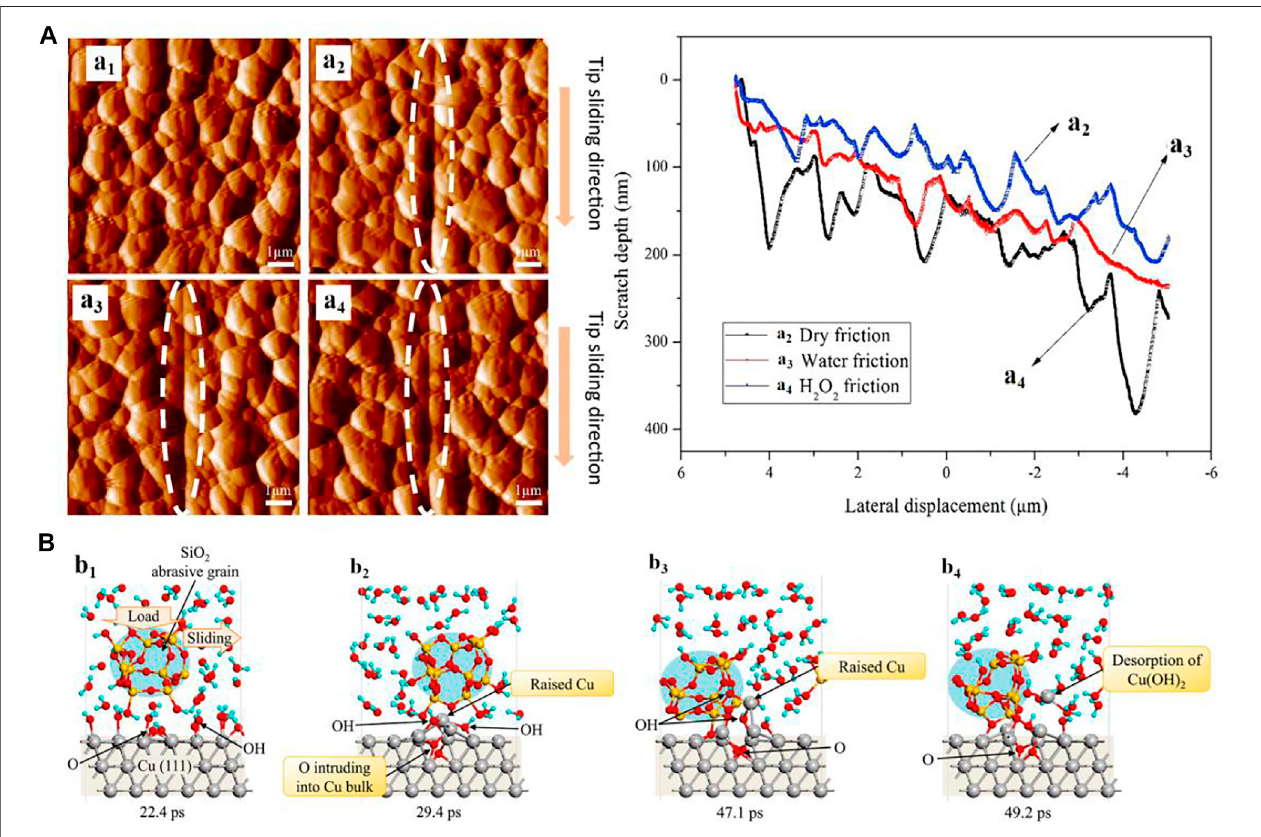
FIGURE 5 | (A) Morphologies of the Al surfaces before (a 1 ) and after the scratch tests in dry condition (a 2 ), DI water (a 3 ), and aqueous H 2 O 2 (a 4 ) with the pro fi les of scratch scars under the corresponding environments (right plots). Adapted from Yongguang Wang et al., 2019 (B) MD simulations showing the tribochemical wear process of Cu (111) sliding against a SiO 2 abrasive grain in H 2 O 2 solution. Adapted from Kawaguchi et al.,